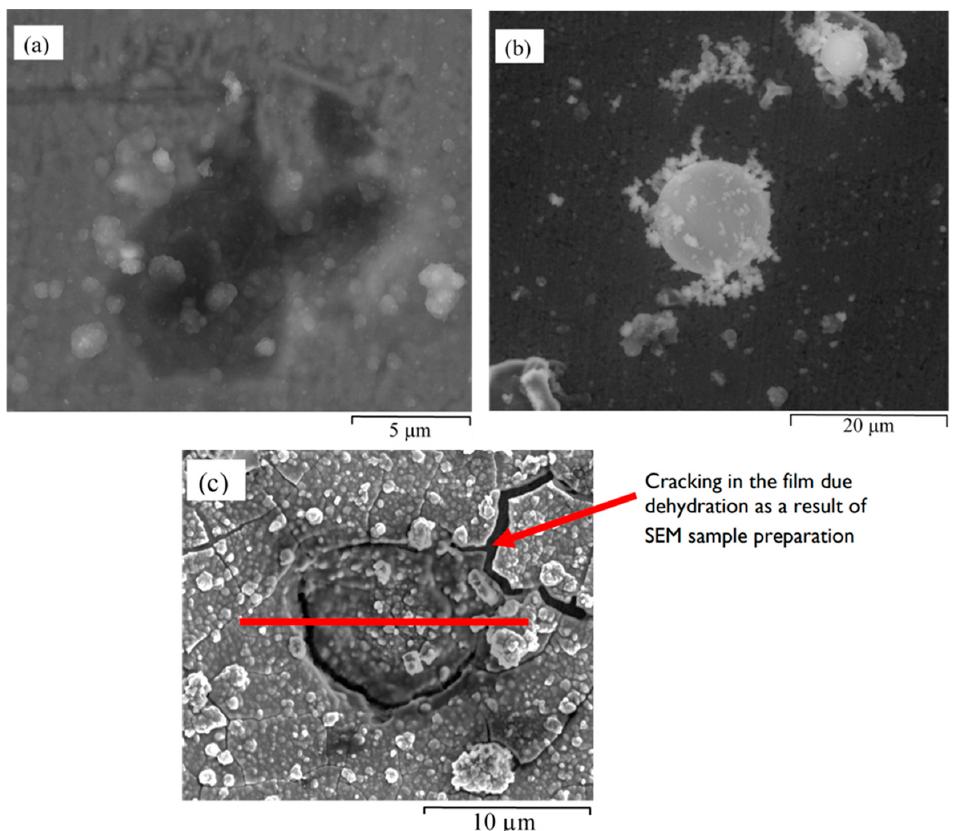
Figure 13. ESEM images of hydrated biofilm formed on carbon steel by a pure IRB culture following 168 h exposure in inorganic medium: ( a ) pits covered under corrosion deposit, ( b ) micro-pits in an area of low corrosion rate, and ( c ) SEM image showing the location where the cross-sectional FIB milling was performed.